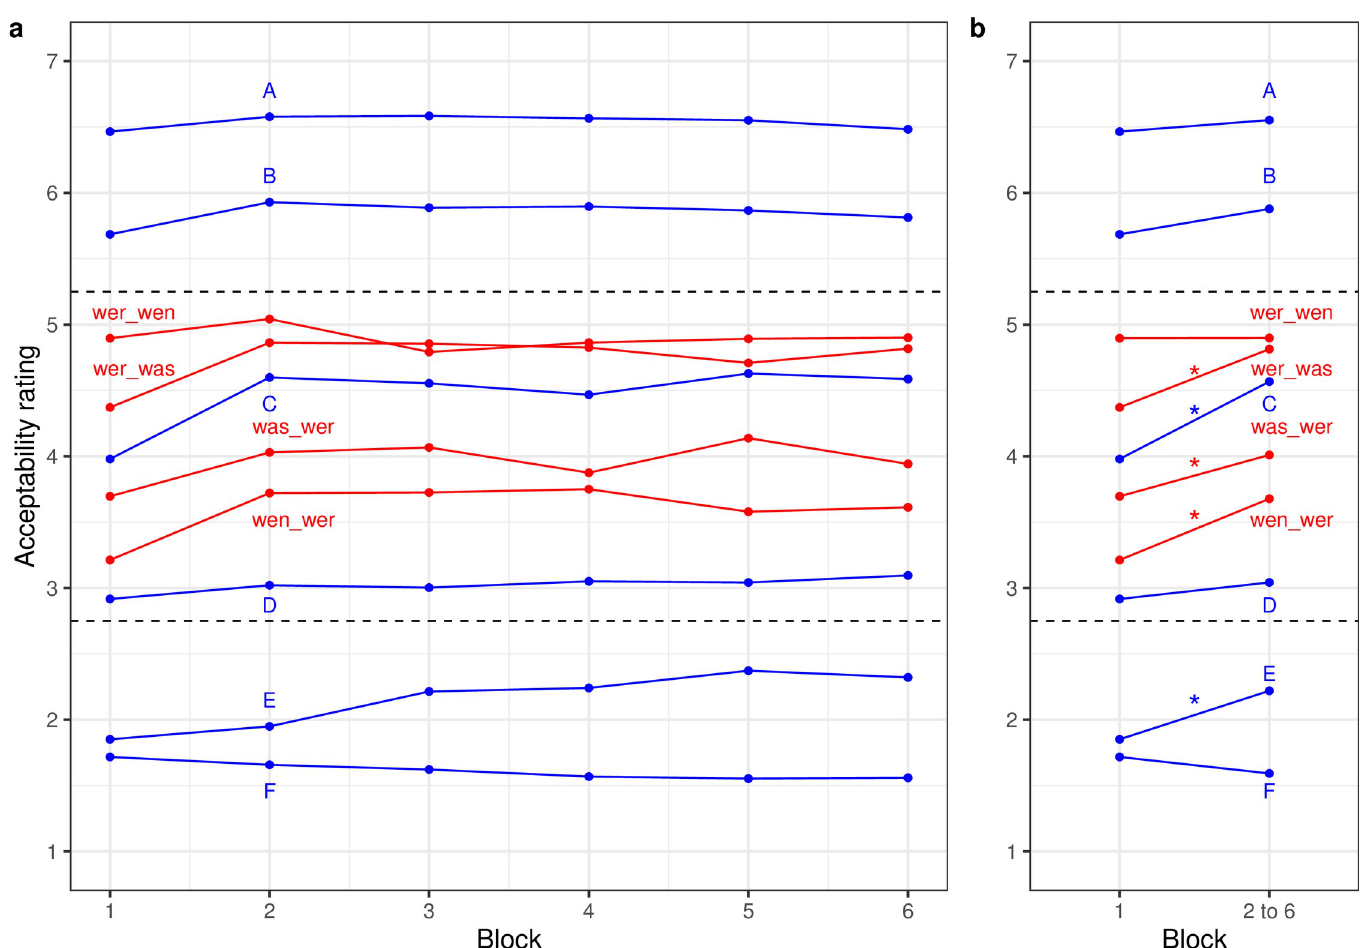
Fig 1. Well-formedness ratings (a) by block and (b) for first block and mean of later blocks for German targets and fillers. Dashed lines indicate the upper and lower bounds of the satiation zone based on the 25% criterion. Asterisks indicate significant changes (p <